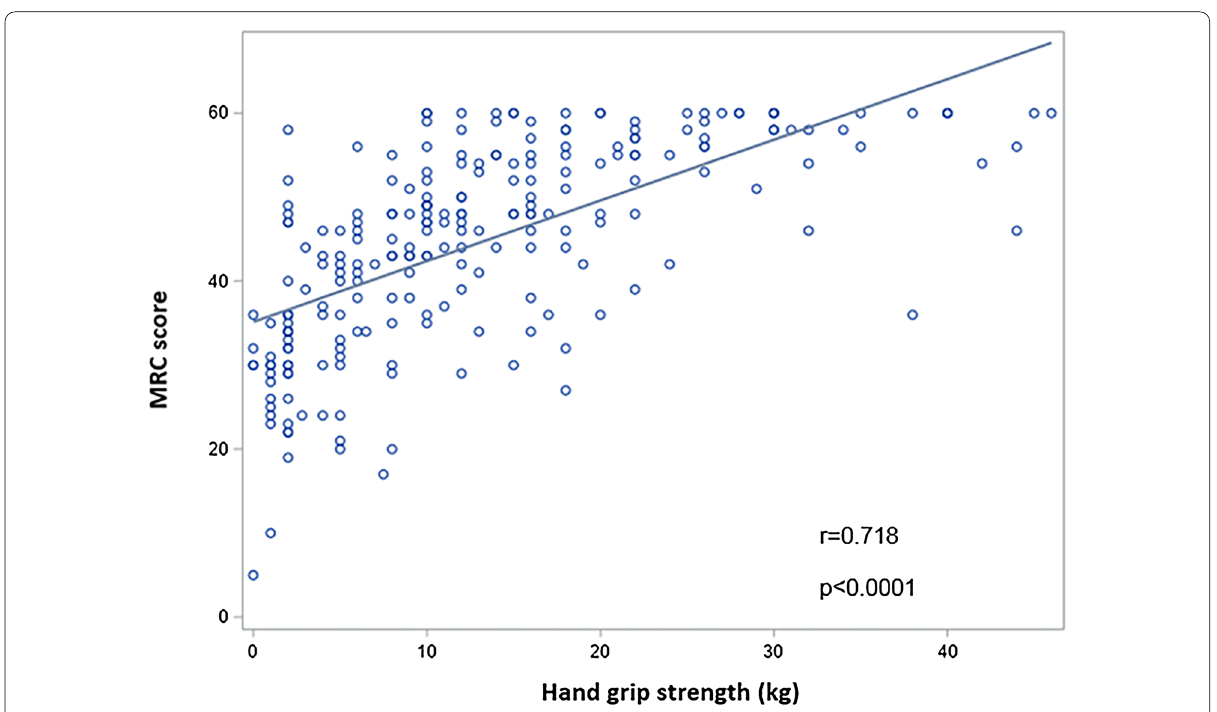
Fig. 2 Association between handgrip strength and MRC